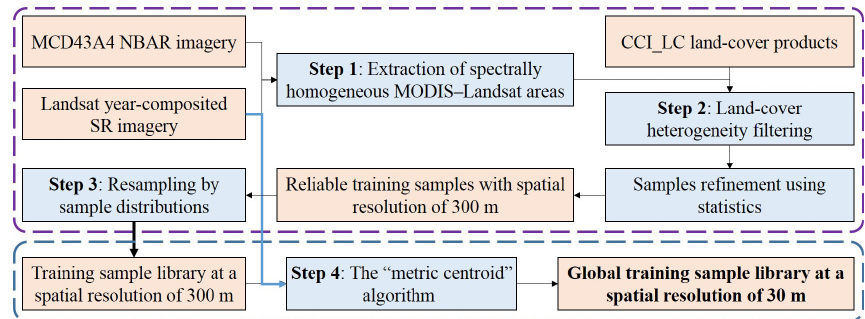
Figure 3. The flowchart of deriving training samples by using multi-source datasets.